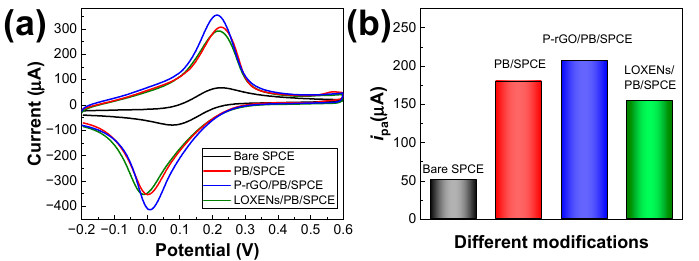
Figure 3. ( a ) CV results of the modified biosensors (bare SPCE, PB/SPCE, P-rGO/PB/SPCE, and LOX- ENs/PB/SPCE) in 5 mM K 3 [Fe(CN) 6 ] prepared in 0.1 M KCl at 50 mV s − 1 . ( b ) The corresponding i pa values plot.